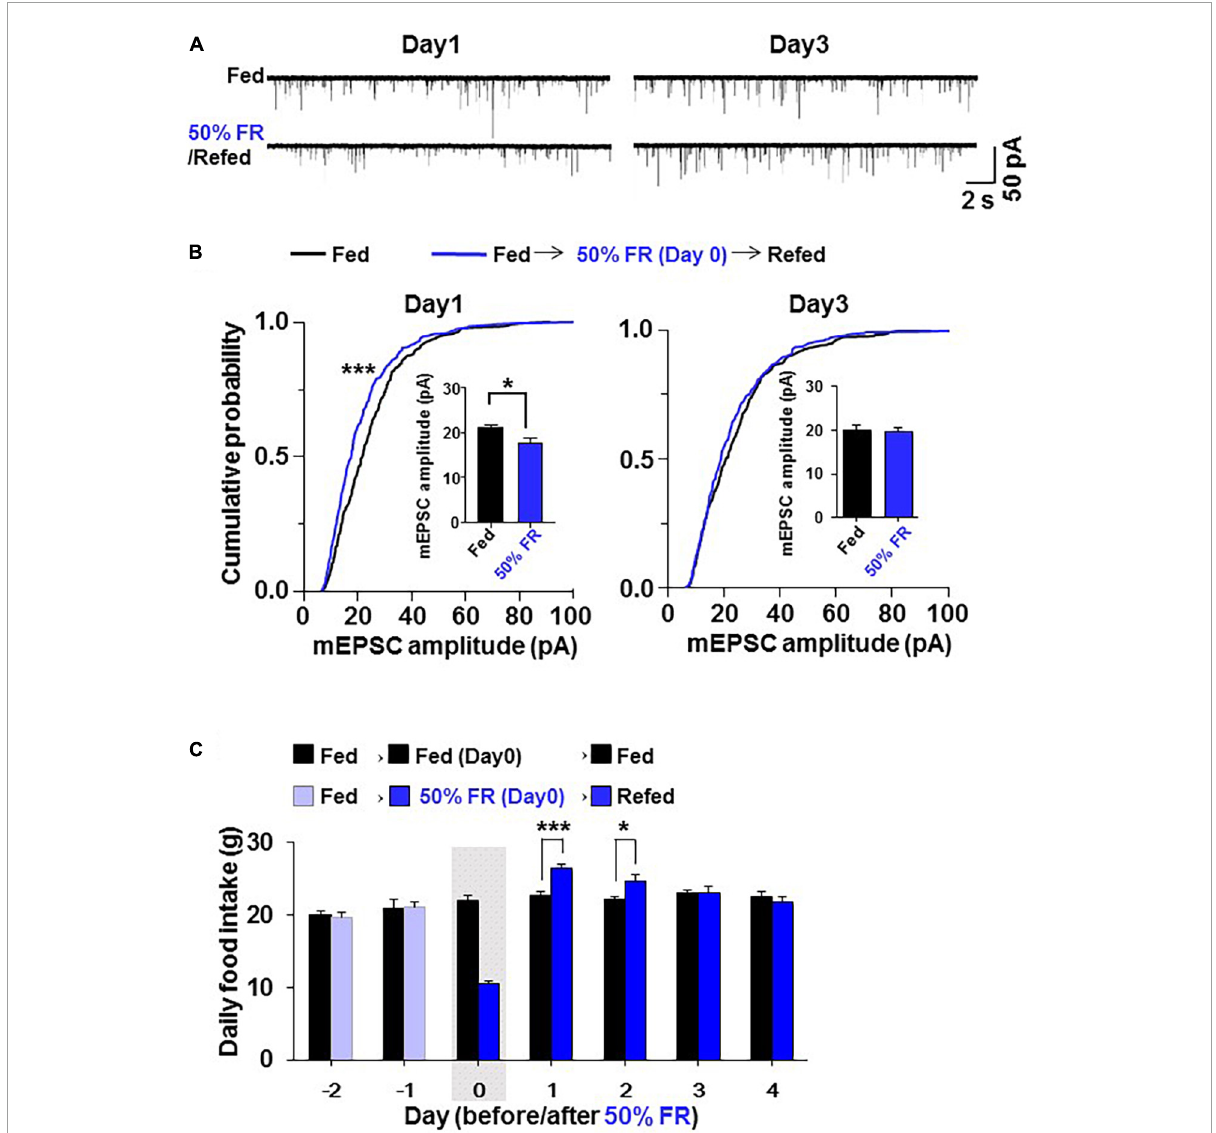
FIGURE6 50% food restriction (FR) induces synaptic depression and hyperphagia less potently than 24 h FR. In the 50% FR group, 50% of the food consumed under the control ad-lib fed condition was given on Day 0 to oxytocin (OXT) mRFP rats, followed by feeding and patch-clamp studies on Days 1–4. (A) The effect of 50% FR, compared to the fed condition, on miniature excitatory postsynaptic current (mEPSC) in paraventricular nucleus (PVN) OXT neurons. (B) 50% FR left-shifted cumulative probability distribution and reduced the average of mEPSC amplitudes (insert) in PVN OXT neurons on Day 1 but not Day 3 of re-feeding. n = 7. *** P < 0.001 by Kolmogorov–Smirnov test. * P < 0.05 by unpaired t -test. (C) 50% FR, compared to the fed condition, resulted in elevated daily food intake on Days 1 and 2 but not Days 3 and 4 of re-feeding. The gray shadow indicates the day of 50% FR. n = 5–6. * P < 0.05 and *** P < 0.001 by two-way ANOVA followed by post-hoc Sidak’s test.